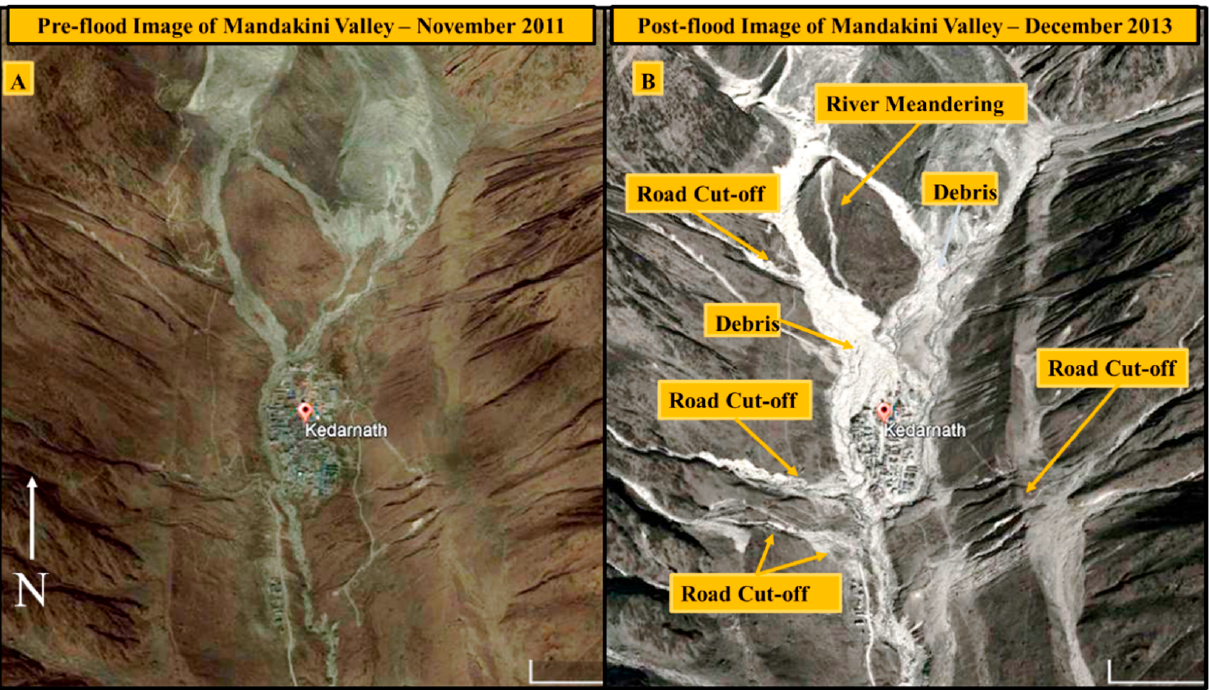
Figure 9. The Google Earth images showing, ( A ) Pre-flood (November 2011), ( B ) Post flood (December 2013) impact of the extreme flash-flood event in the Kedarnath region of the Mandakini river basin. Apart from extreme weather-induced disasters, the region also suffers from landslides and avalanches. In 2021, the Chamoli region experienced a flash-flood event resulting from an avalanche near the Ronti Glacier (Figure 10) at an elevation of 4064 m. At the confluence of the Rishi and Dhauliganga rivers, the height is 1908 m, while Nanda Devi, at 7817 m, is the highest point in the region. The floods, while travelling downstream, demolished the bridge near Raini village, damaged the Rishiganga and the National Thermal Power Corporation (NTPC) Tapovan Hydel plant, and killed over 200 people [45]. The velocity and flood discharge at 89 m upstream of the Rishiganga Dam is estimated to be 24 m/s and 12,448 cumecs. The length of the rockslide surface is about 1182 m, having a maximum width of 755 m and a mean slope of 62 ◦